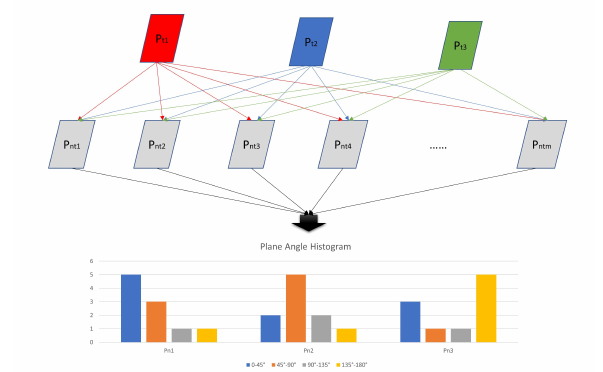
Figure 2. Histogram of plane angles.